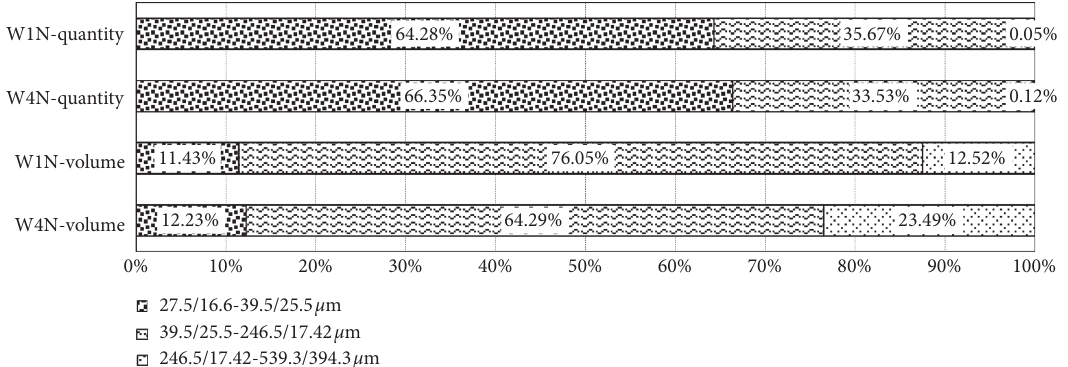
Figure 27: Quantity and volume proportion in different gel equivalent-diameter ranges of NCG concretion by